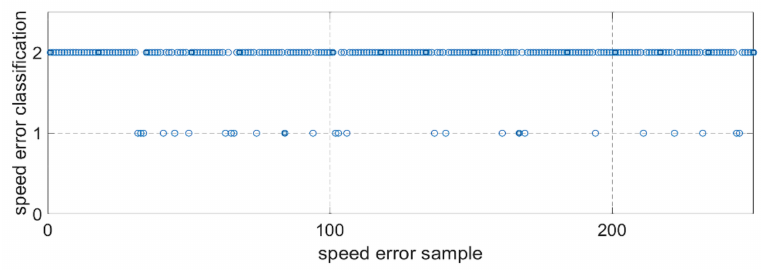
Figure 9. Part of the speed sample classification results by IGSA-IPNN.